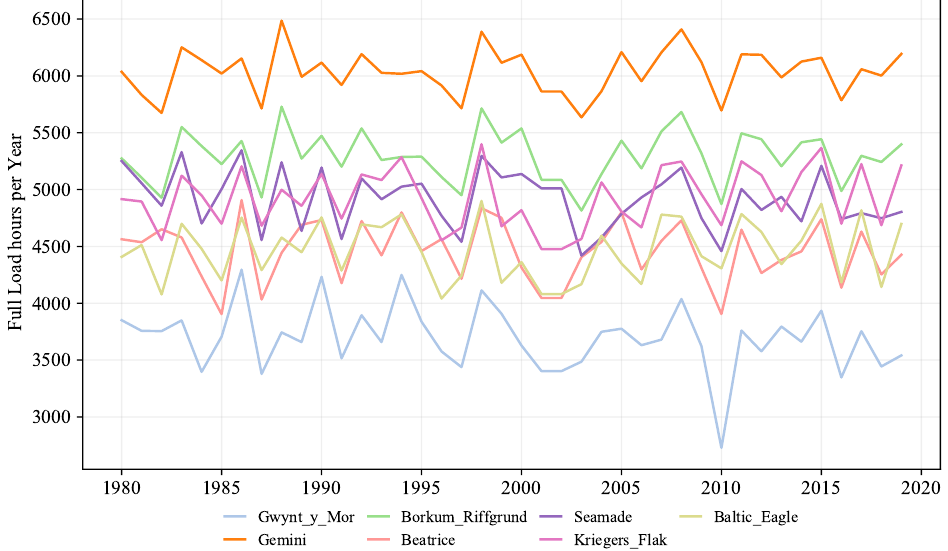
Figure 6. Histograms of generated power from different wind farms in 2019.